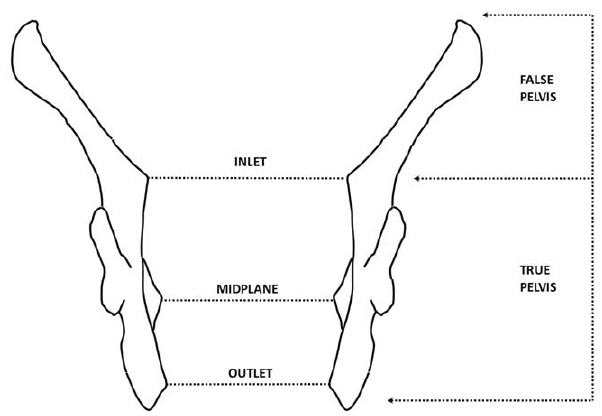
Figure 1. Diagram of the true and false pelvis. Inlet, midplane and outlet refer to the different planes of the birth canal (figure redrawn after [51,65,66]).